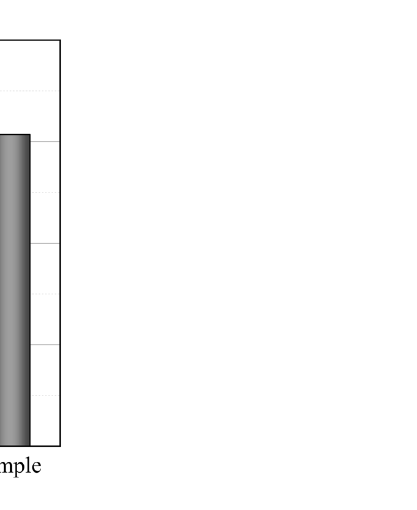
Figure 19. Area-averaged h g / h i for film hole model with α =